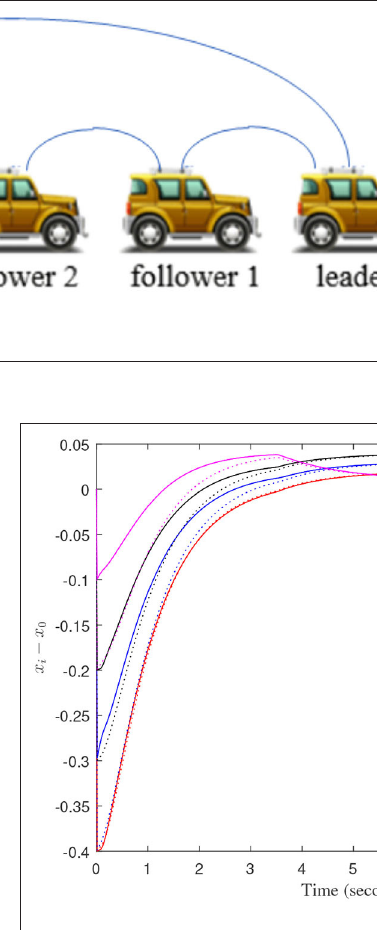
FIGURE 3 | The velocity error between the follower car and the leader car.